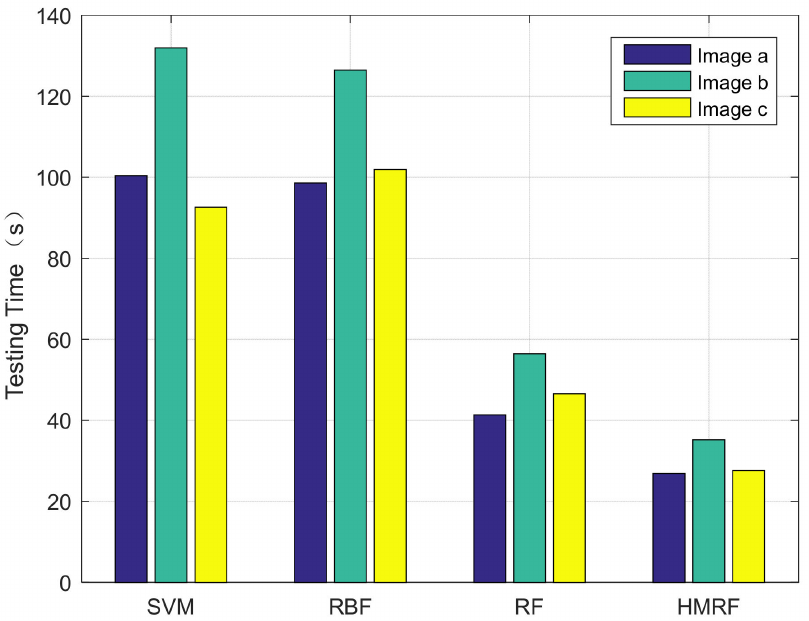
Figure 6. Comparison of different algorithms in testing